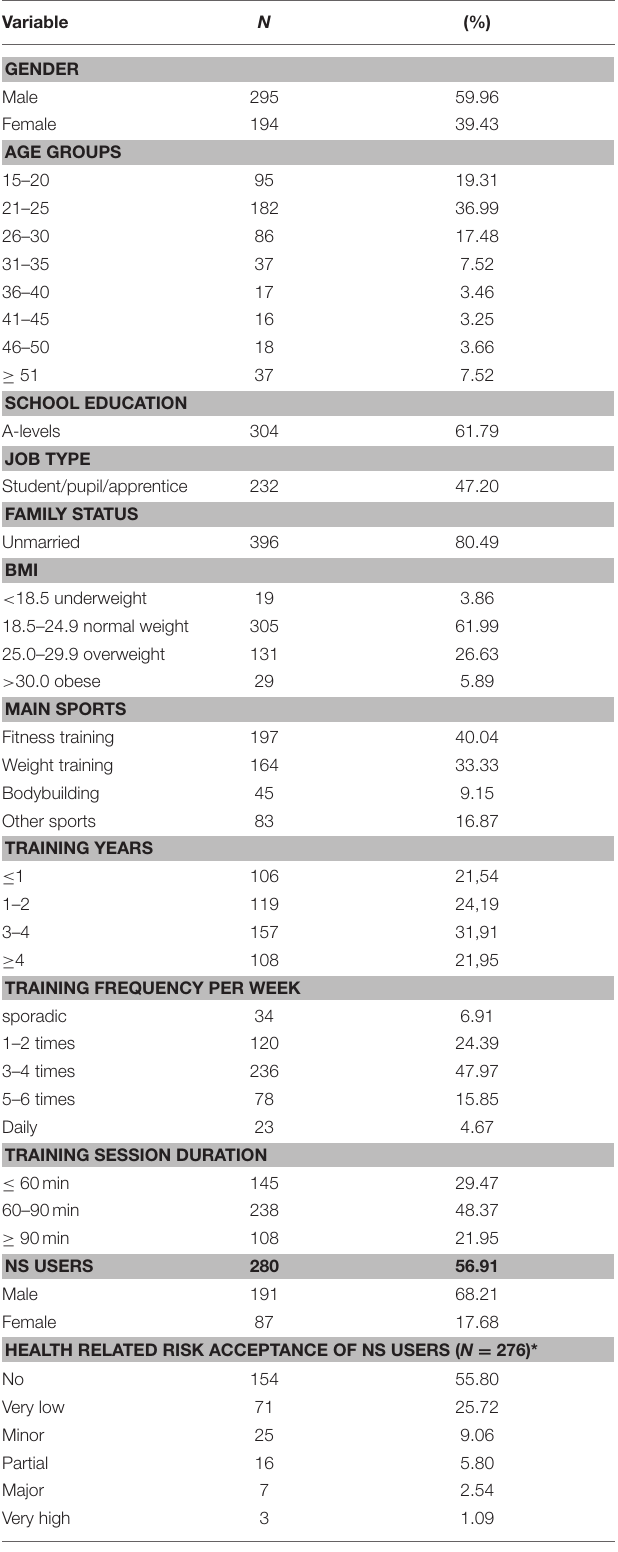
TABLE 1 | Basic characteristics of 492 fitness studio